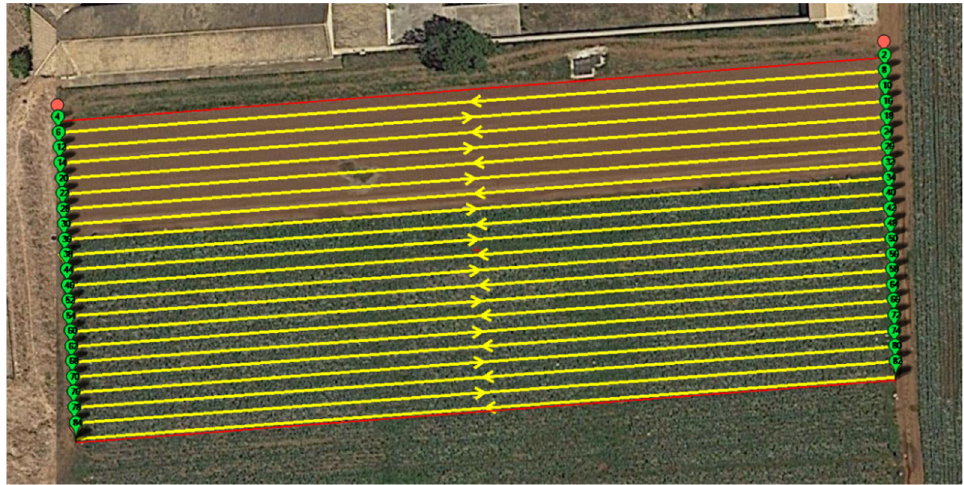
Figure 4. The flight mission executed by the UAV.